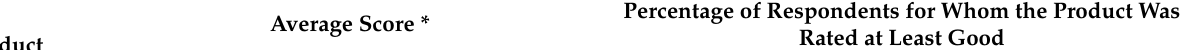
Table 4. Structure of attitudes of respondents’ opinions in terms of perceiving the problem of deliberate product aging by producers in subgroups determined by the type of declared behavior when the product broke after the warranty period. Procedure When the Product Breaks Down after the Warranty Period ( X 6 ): Opinion on the Correctness of the Phrase “Manufacturers Deliberately Age Products So Purchase a New One Purchase a New One Repair Broken That Customers Make and Throw Away the and Store the Broken Equipment and Use It Purchases More Often” ( Y ) Broken Product Product at Home Further Rather no Hard to say Rather yes Definitely yes